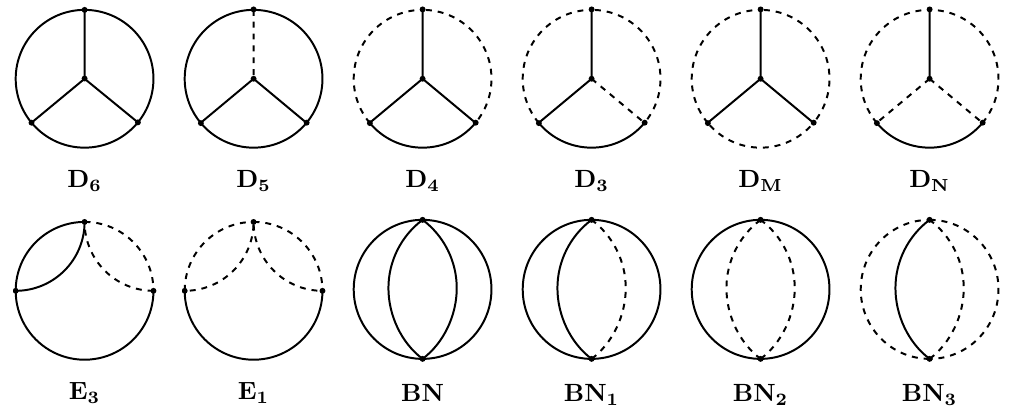
Figure 1. Full set of non-factorizing master integrals. Solid and dashed lines correspond to massive and massless scalar propagators, respectively.